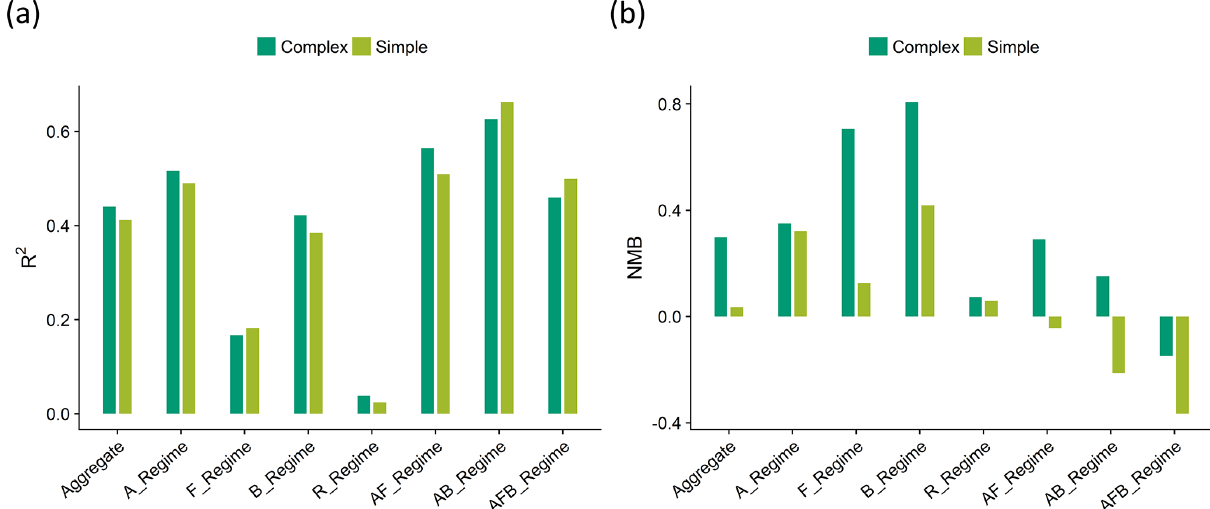
Figure 10. Statistical evaluation of the OA model skill for the complex (dark green) and simple (light green) scheme against observations shown as (a) the coefficients of determination ( R 2 ) and (b) the normalized mean bias (NMB) across the segmented regimes. A positive normalized mean bias indicates that the model overpredicts OA loadings.